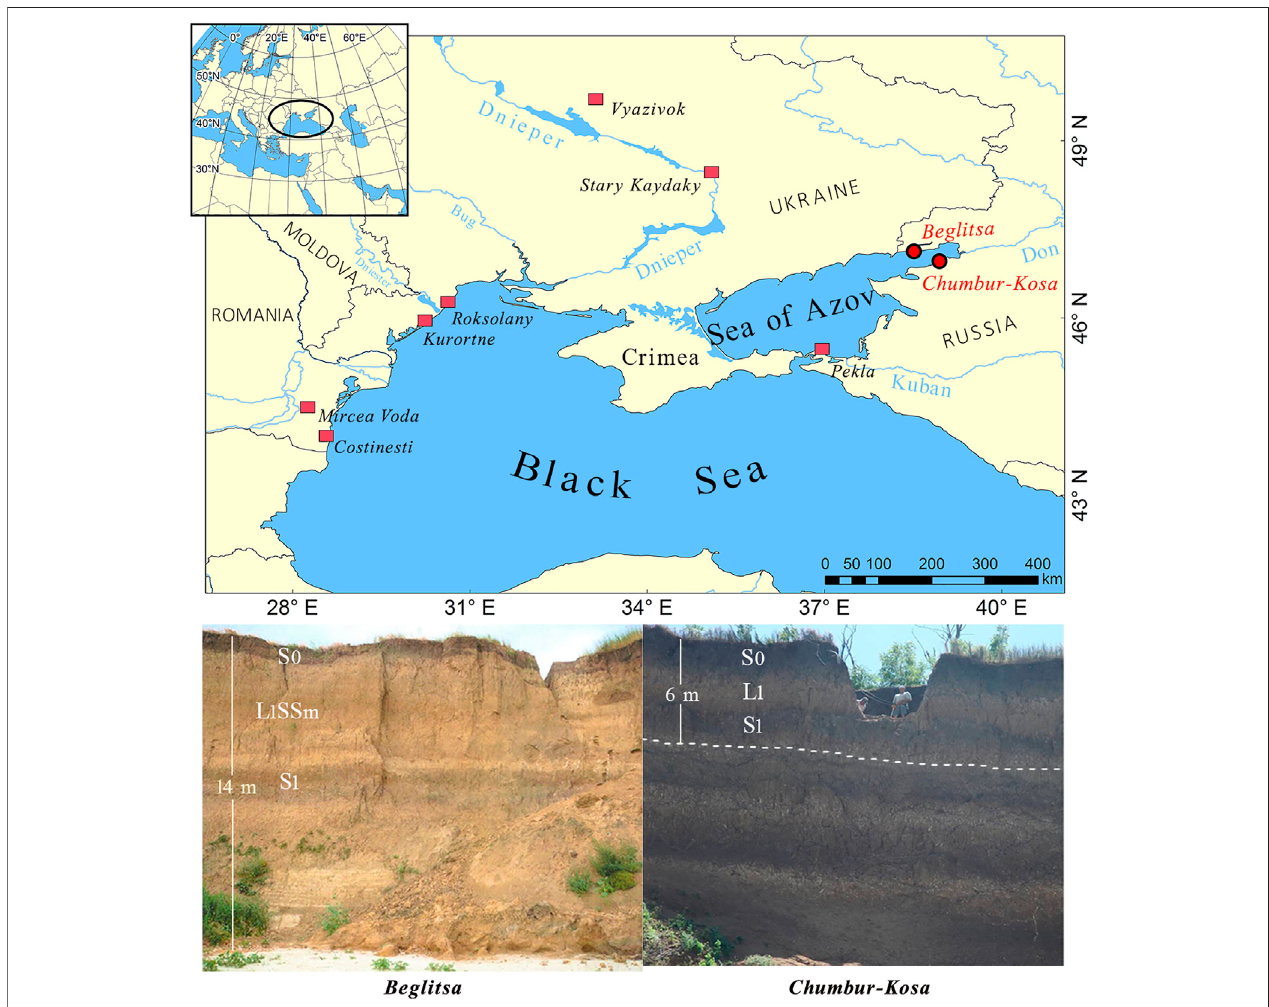
FIGURE 1 | Study region and location of the investigated loess – paleosol sequences (LPSs) in this study indicated with red solid circles and other important LPSs mentioned in the main text represented by red solid rectangles. Photographs of the studied LPS sections are also shown.